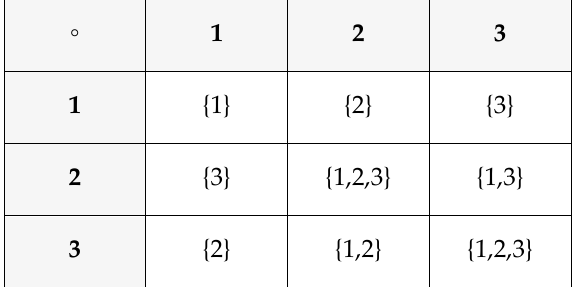
Table 18. Right almost-hypergroup with right scalar